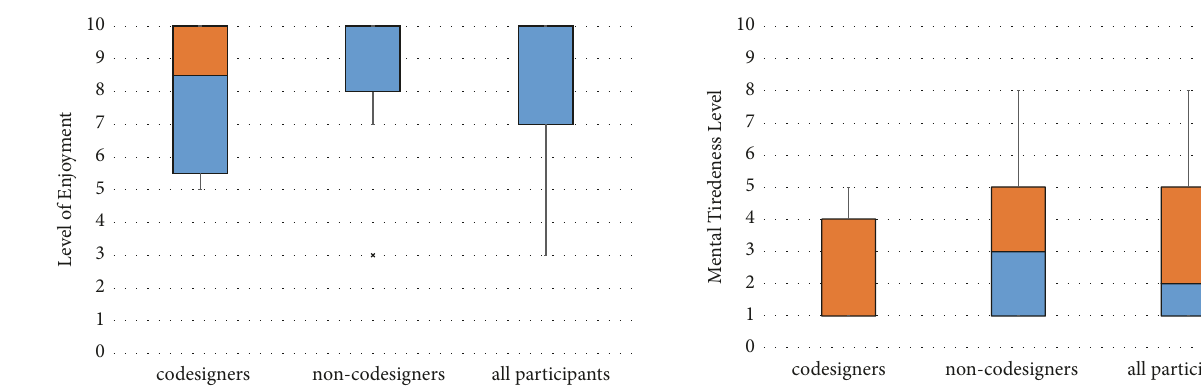
Figure 20: Answers from topic 13 of Table 9: this topic measures mental fatigue after playing the game.